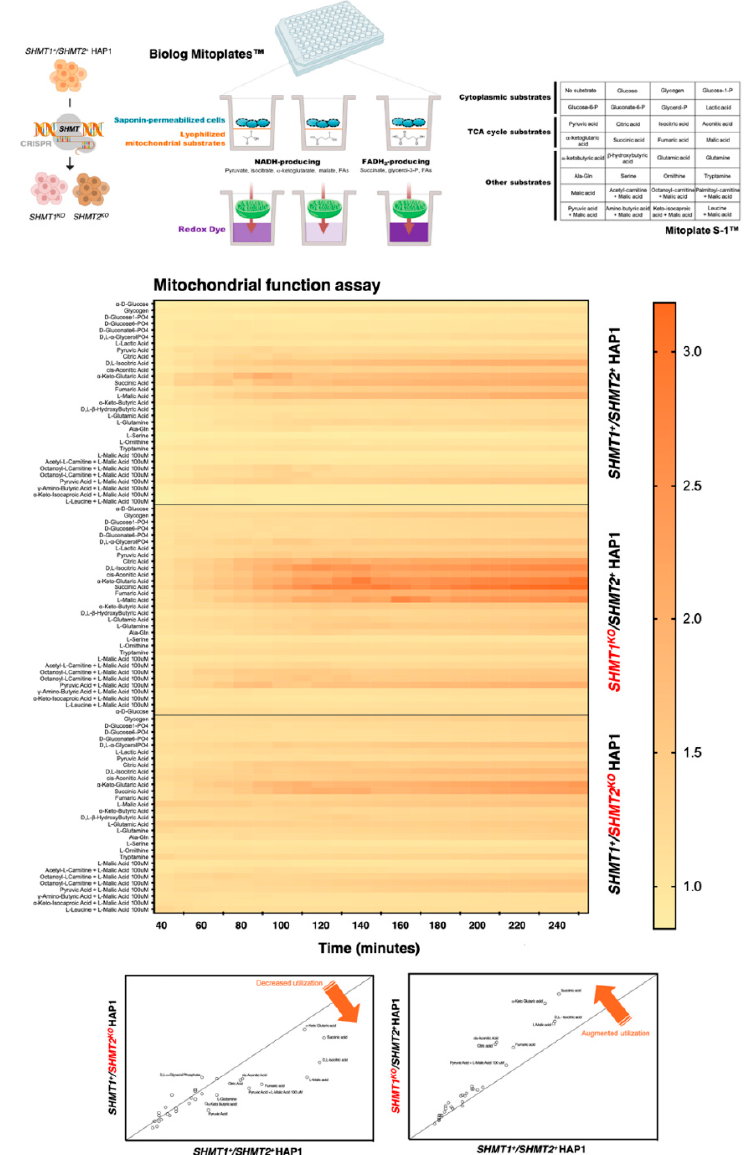
Figure 8. Depletion of SHMTs alters the mitochondrial functioning in HAP1 cells Top. Mitochon- drial phenotyping of HAP1 cells upon SHMT1 and SHMT2 loss using Mitochondrial Function Assays with Biolog Mitoplates. Mitochondrial function in HAP1 parental and SHMT2-KO HAP1 counterparts was assayed by measuring the rates of electron flow into and through the electron trans- port chain (ETC) for cytoplasmic, TCA cycle, and other metabolic substrates producing NAD(P)H (pyruvate, isocitrate, α -ketoglutarate, malate, fatty acids) or FADH 2 (succinate, glycerol-3-phosphate, fatty acids). The electrons travel from the beginning (complex I or II) to the distal portion of the ETC where a tetrazolium redox dye (MC) acts as a terminal electron acceptor that turns purple upon reduction. Bottom. Figure Shows the heatmap of the metabolic substrate consumption of fatty acids, glycolysis, amino acids, and TCA cycle metabolites in HAP1 and SHMT2-KO HAP1 cells. Changes in pathway-specific consumption reveal that SHMT2-KO HAP1 cells consumed notably less TCA substrates than HAP1 parental